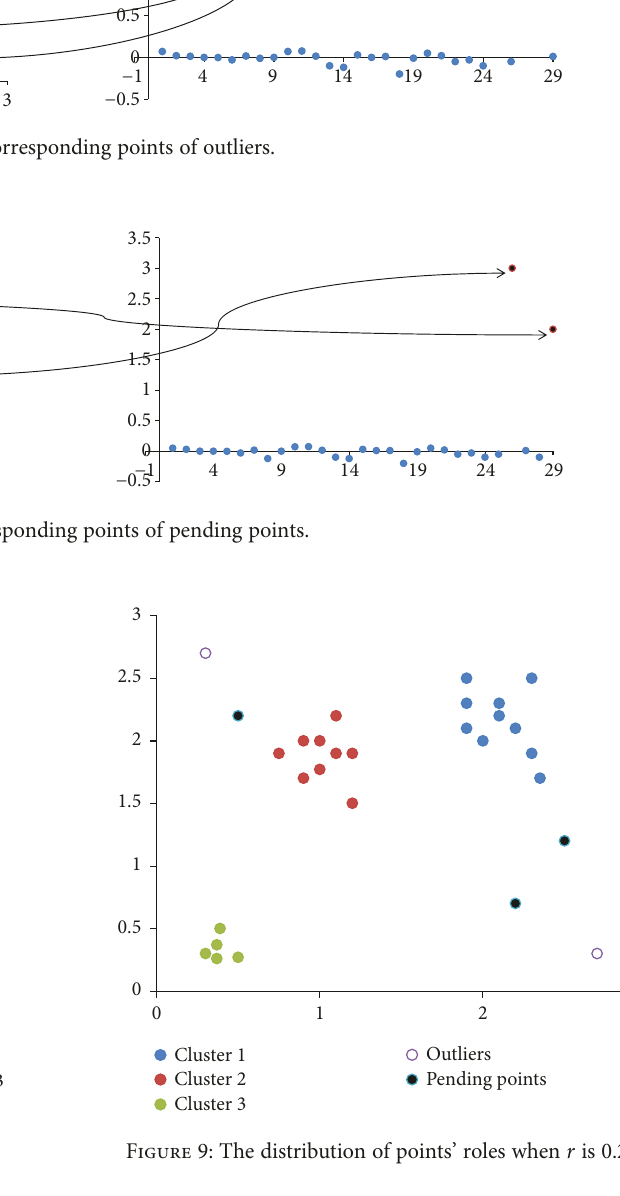
Figure 8: The distribution of points ’ roles when r is 0.25.